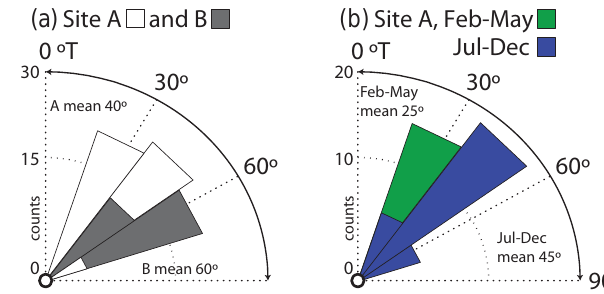
Figure 8. Propagation direction distribution for each packet of